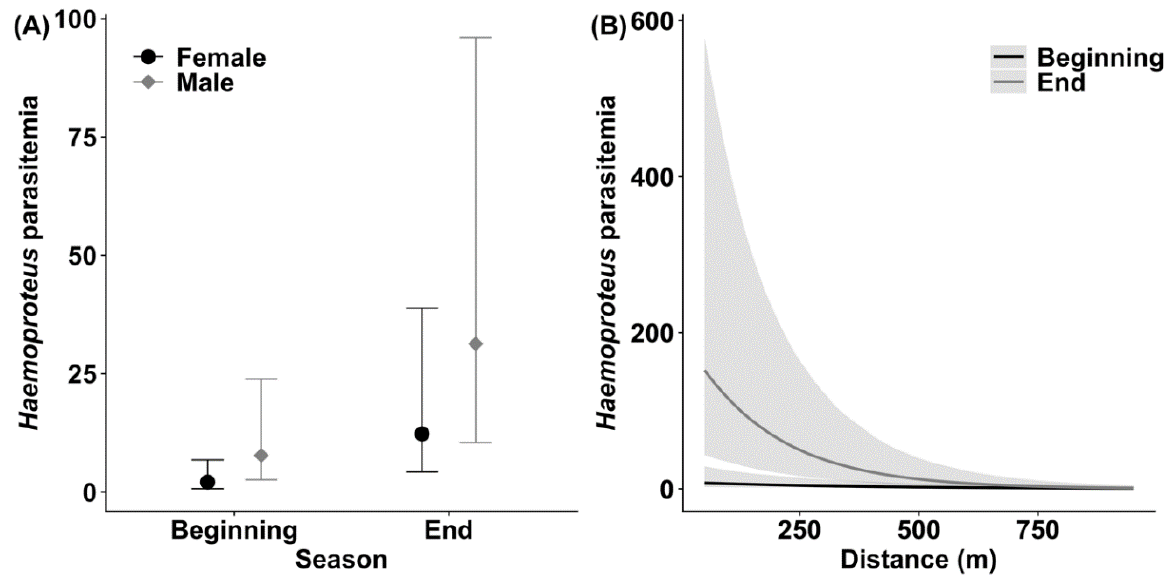
Figure 2. ( A ) Haemoproteus parasitemia in male and female Pied Flycatchers at the beginning and the end of the breeding season. Error bars represent 95% credibility intervals. ( B ) The relationship between the Haemoproteus parasitemia and the distance to the nearest water bodies at the beginning and the end of the breeding season. Solid lines show the estimated trendlines by the model, and grey-shaded areas represent 95% credibility intervals.